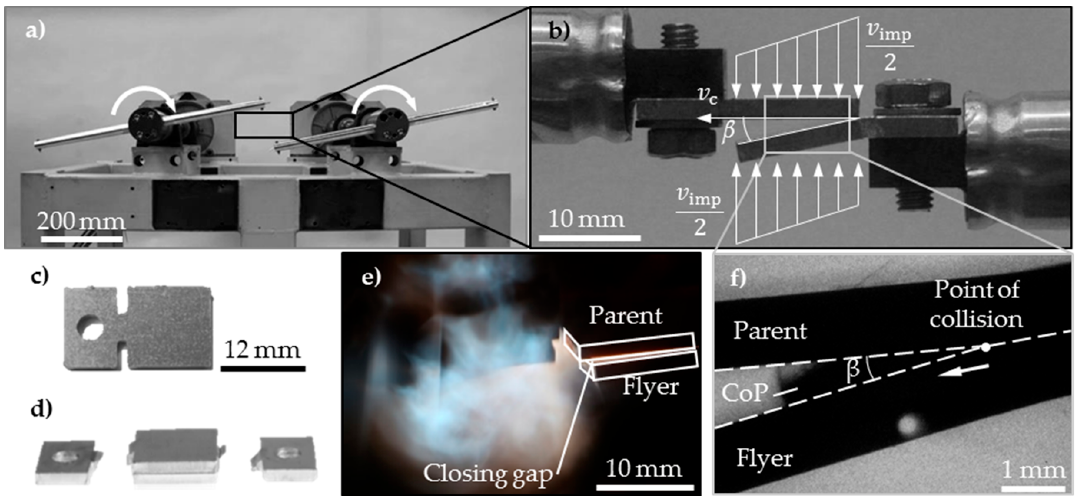
Figure 2. ( a ) Test rig assembly [35], ( b ) shown in detail: mounted joining partners and the resulting process parameters [35], ( c ) geometry of the specimen in the test rig and welded specimens [14], ( d ) welded specimens [35], ( e ) process glare with two seconds exposure time, ( f ) high-speed image of the collision welding process with 20 ns exposure time and measured collision angle β [14]. ( a , b , d ) are reproduced from [35], with permission from Elsevier, 2017; ( c , f ) are reproduced from [14], with permission from John Wiley and Sons, 2019.